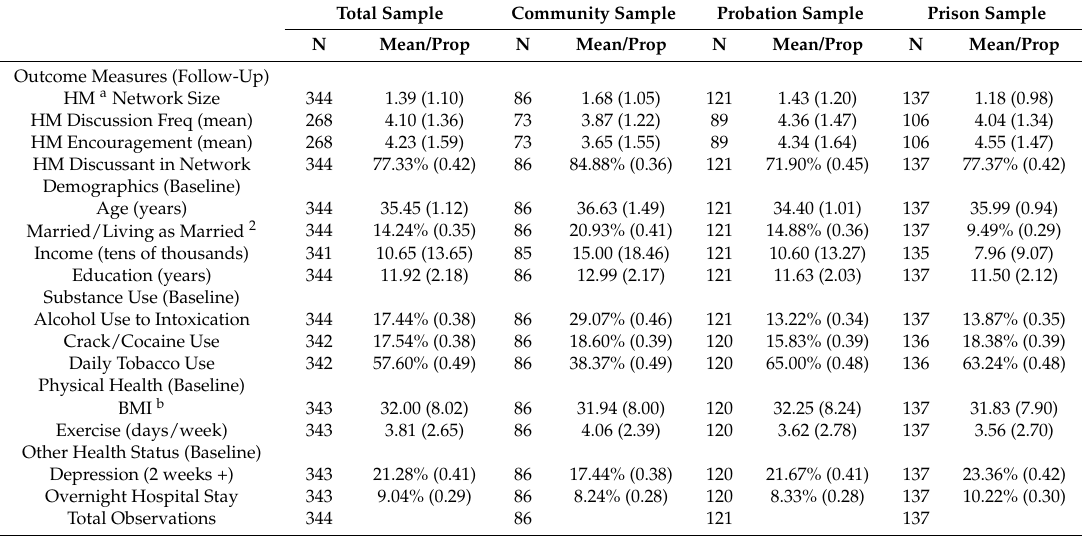
Table 1. Demographics for the total sample and the community, probation, and prison